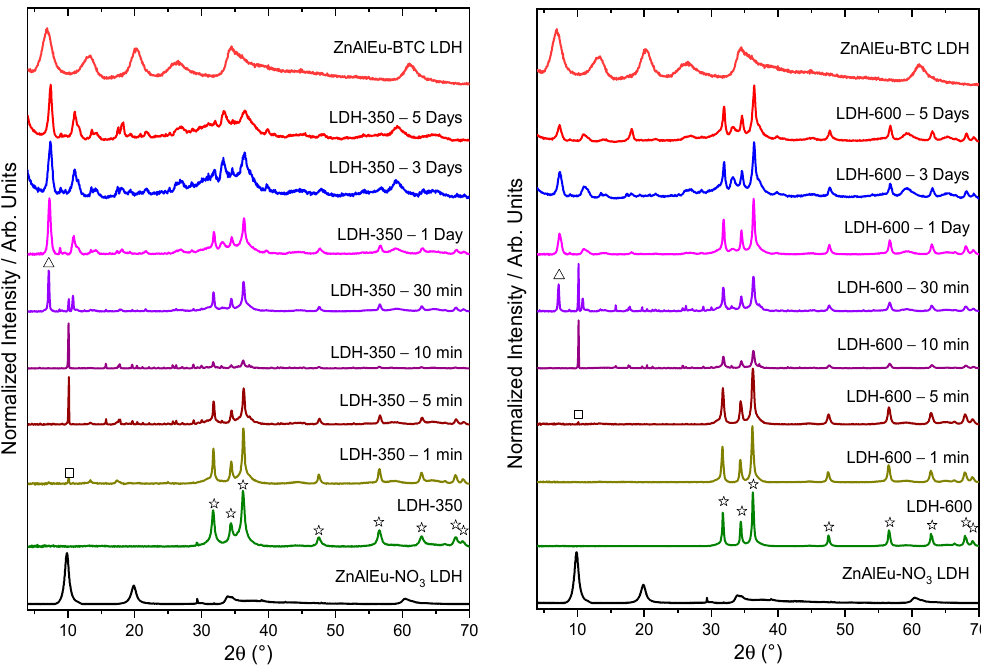
Figure 5. Powder X-ray diffraction patterns for different hydration times of ZnAlEu–NO 3 LDH samples calcined at 350 ◦ C ( left ) and 600 ◦ C ( right ). Starred peaks relate to the formation of a ZnO phase. Reflections associated with the reappearance of a layered phase are marked with open squares, while the basal reflections of LDH intercalated with BTC (7.0 ◦ , 12.7 Å) are marked with an open triangle. The PXRD patters of the samples ZnAlEu–NO 3 LDH and ZnAlEu–BTC LDH are shown for comparison.